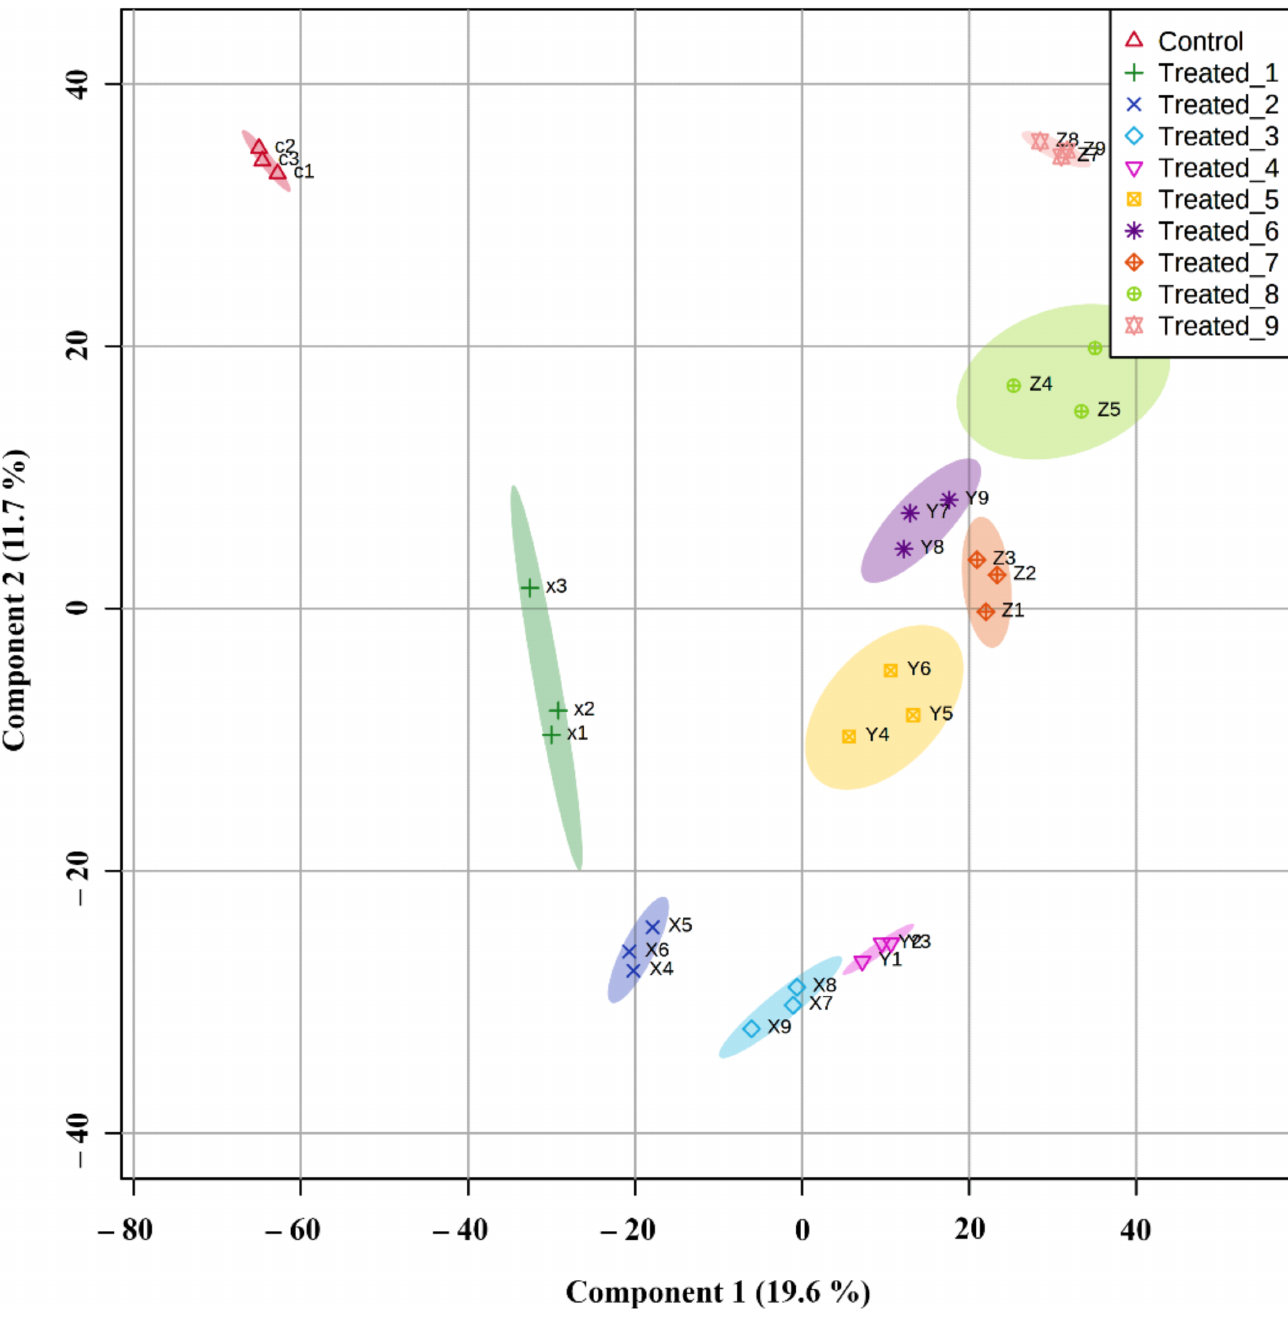
Figure 12. PLS-DA analysis on significantly expressed metabolites allows for grouping of stressed